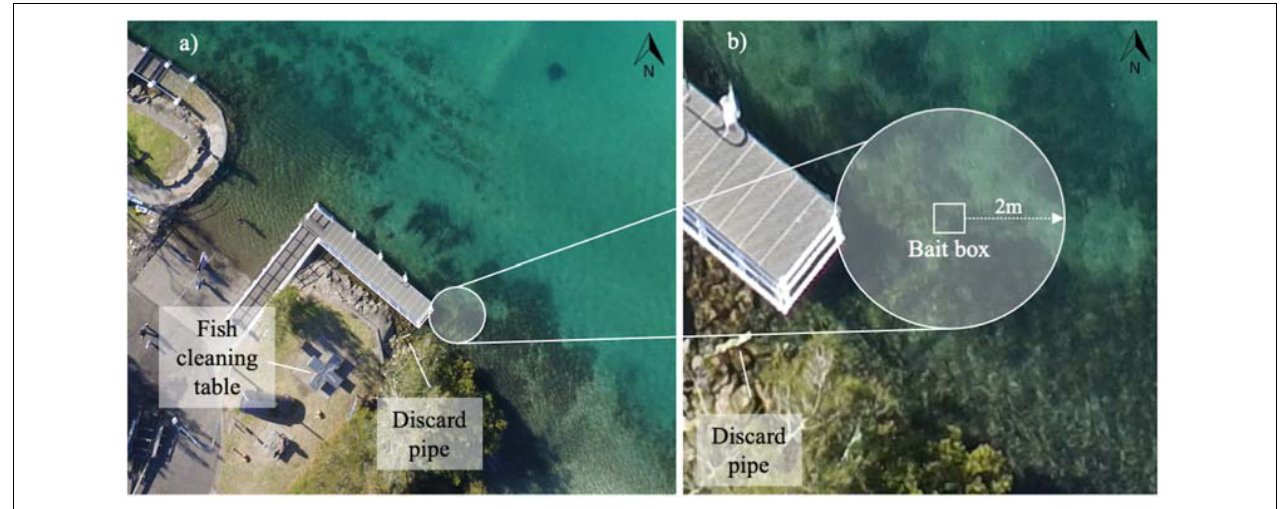
FIGURE 1 | Location of the social interaction zone relative to the cleaning facilities (a) and schematic for the social interaction zone around the bait box (b) .